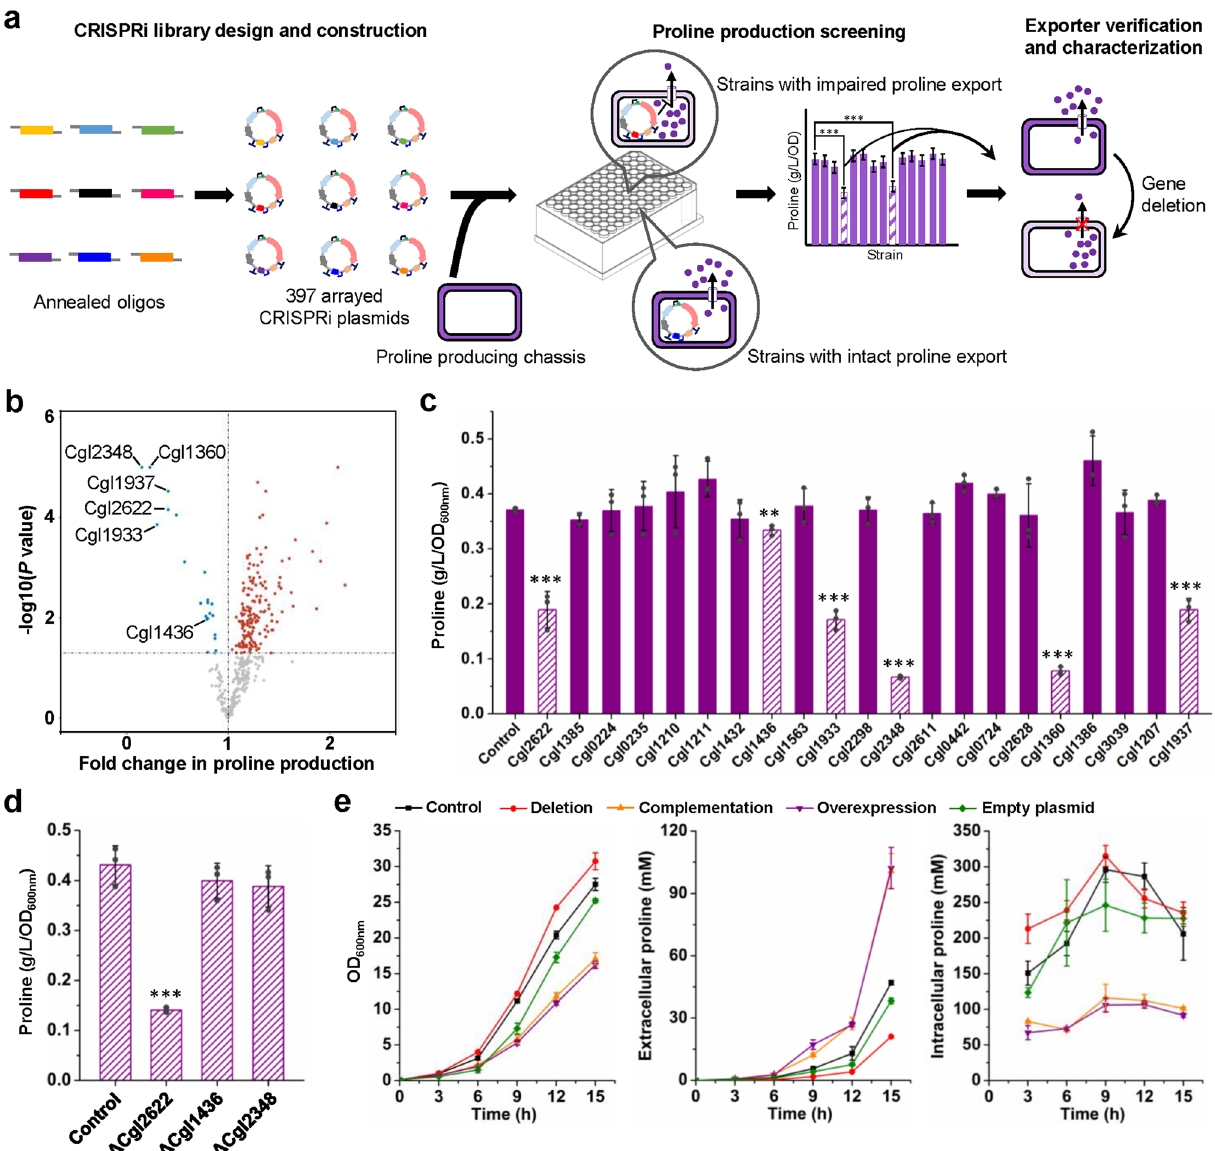
Fig. 6 CRISPRi screening and characterization of L -proline exporter in C. glutamicum . a Work fl ow of screening L -proline exporter by constructing